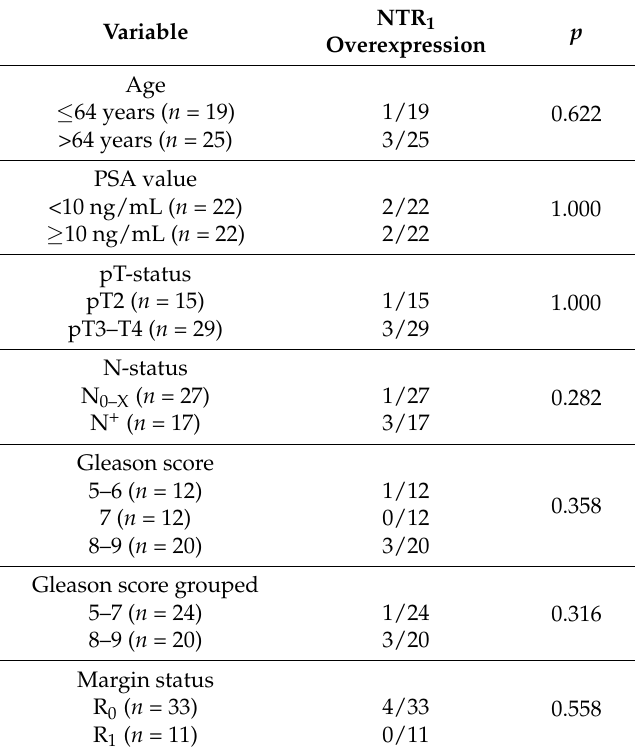
Table 1. Association between NTR 1 expression in primary tumors and clinical and pathological data in 44 patients with prostate